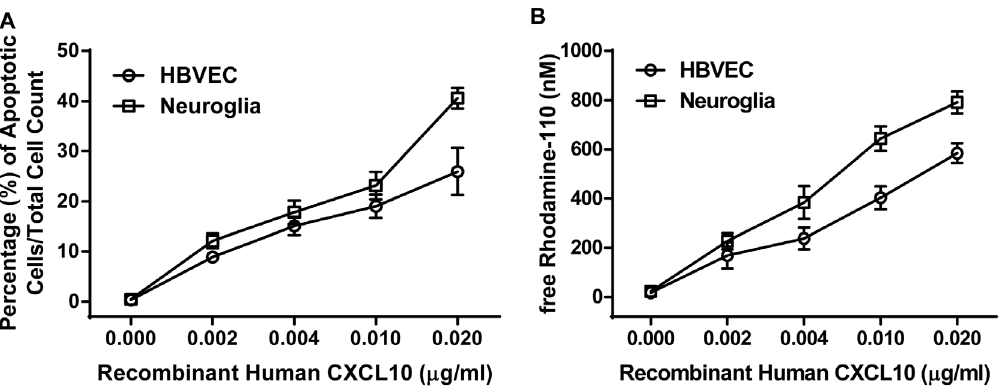
Figure 1. Dose-response apoptotic effect of recombinant human CXCL10 on HBVECs and neuroglia cells. (A) Shown are results of TUNEL assay of percentage of apoptotic HBVECs and neuroglia cells incubated with different concentrations of recombinant human CXCL10 for 24 hour at 37 u C. (B) Homogeneous caspase assay showing HBVECs and Neuroglia cells exposed to different concentrations of recombinant human CXCL10 for 24 hours at 37 u C. Subsequently, the cells were directly incubated with substrate solution for 2.5 hours at 37 u C. The Relative Fluorescence Units (RFU) signal is converted to nM free Rhodamine via standard curve. The increase of the caspase activity was calculated as difference of the RFU signal of the induced cells to the RFU signal of non-induced cells. Bars represent standard deviations of three experiments.